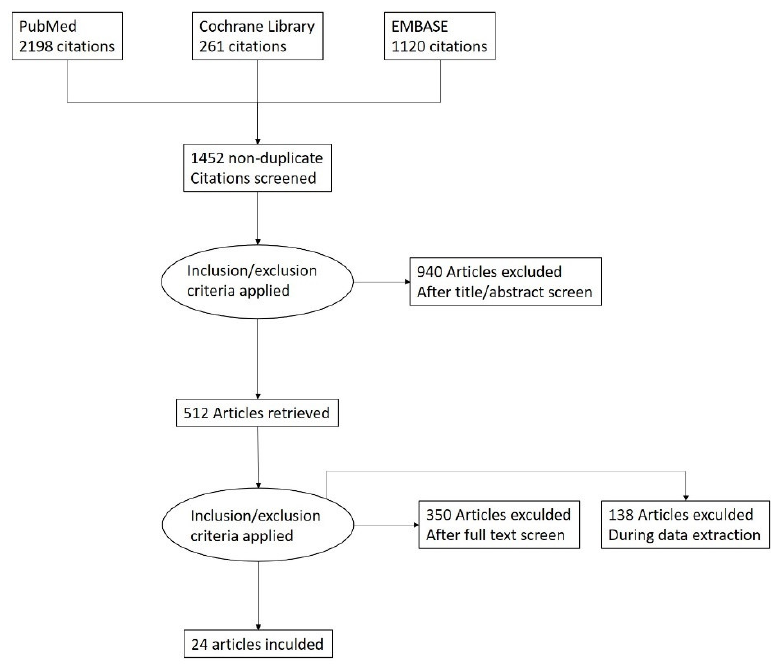
Figure 1. PRISMA flow diagram .